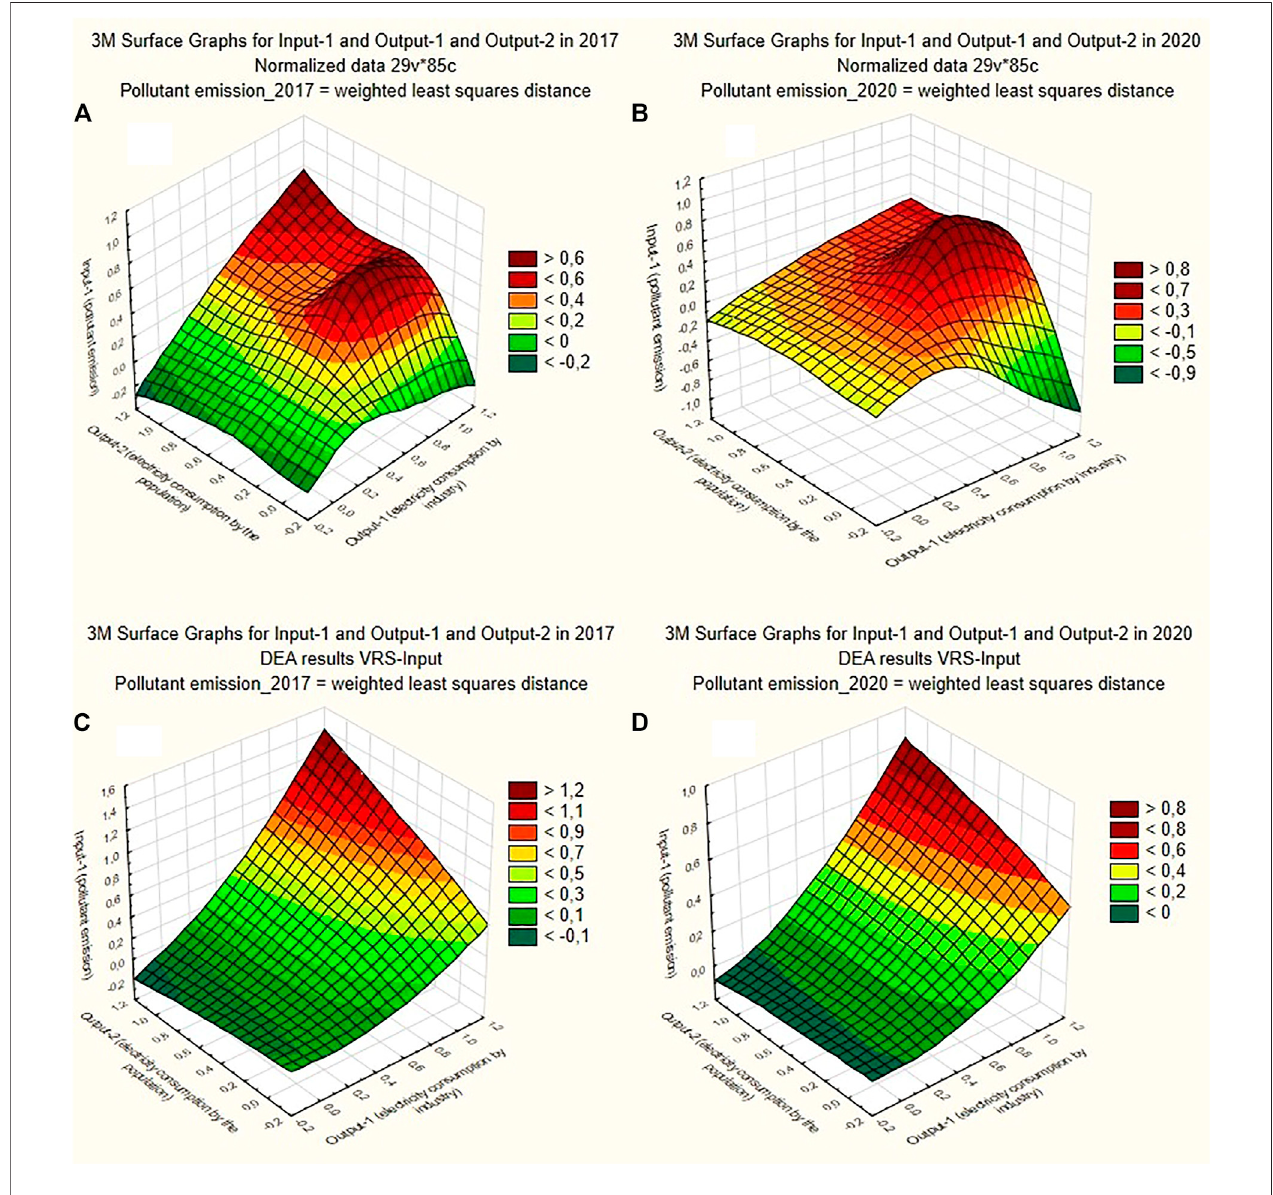
FIGURE 1 | Surface graphs for real data in 2017 (A) and 2020 (B) and results of VRS models with one input and two outputs in 2017 (C) and 2020 (D) .